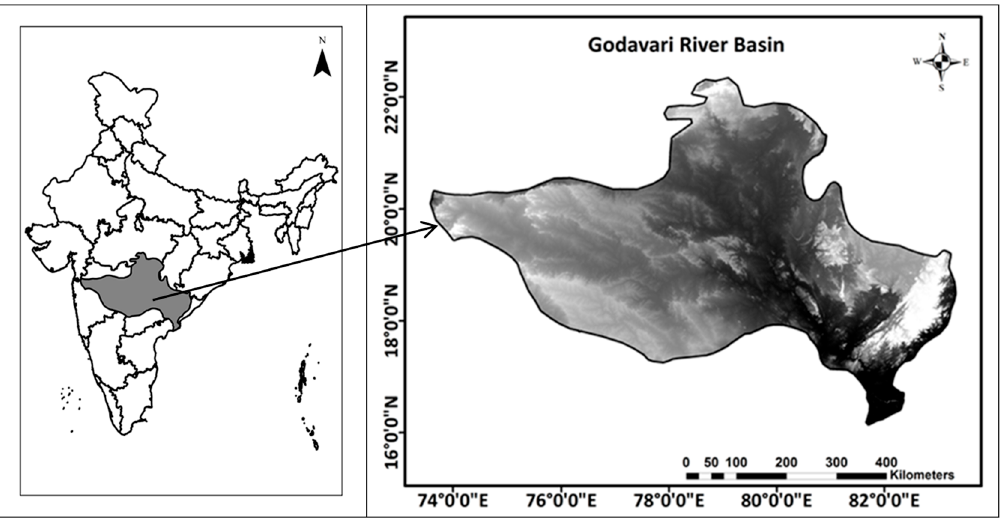
Figure 1. Location map of the study area of the Godavari River basin, covering 73°26 ′ E to 83°07 ′ E longitudes, and 16°16 ′ N to 23°43 ′ N latitudes.